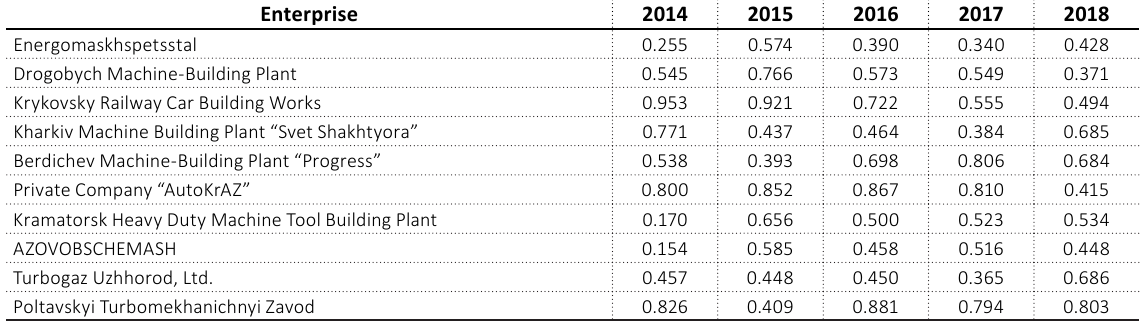
Table C1. An integral indicator of taxonomy of Ukrainian machine-building enterprises for 2014–2018 Enterprise